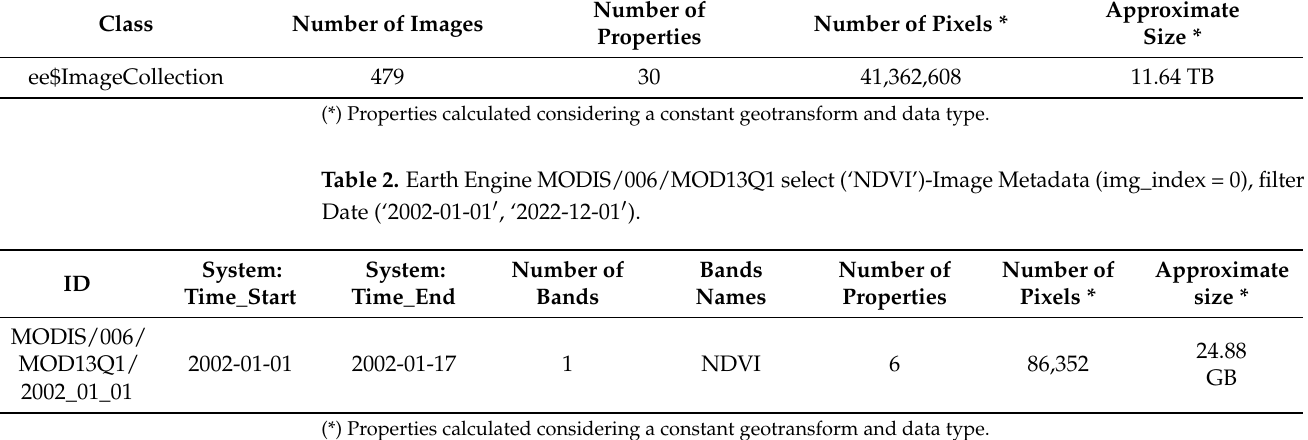
Table 3. Earth Engine MODIS/006/MOD13Q1 select (‘NDVI’)-Band Metadata (img_band = ‘NDVI’),